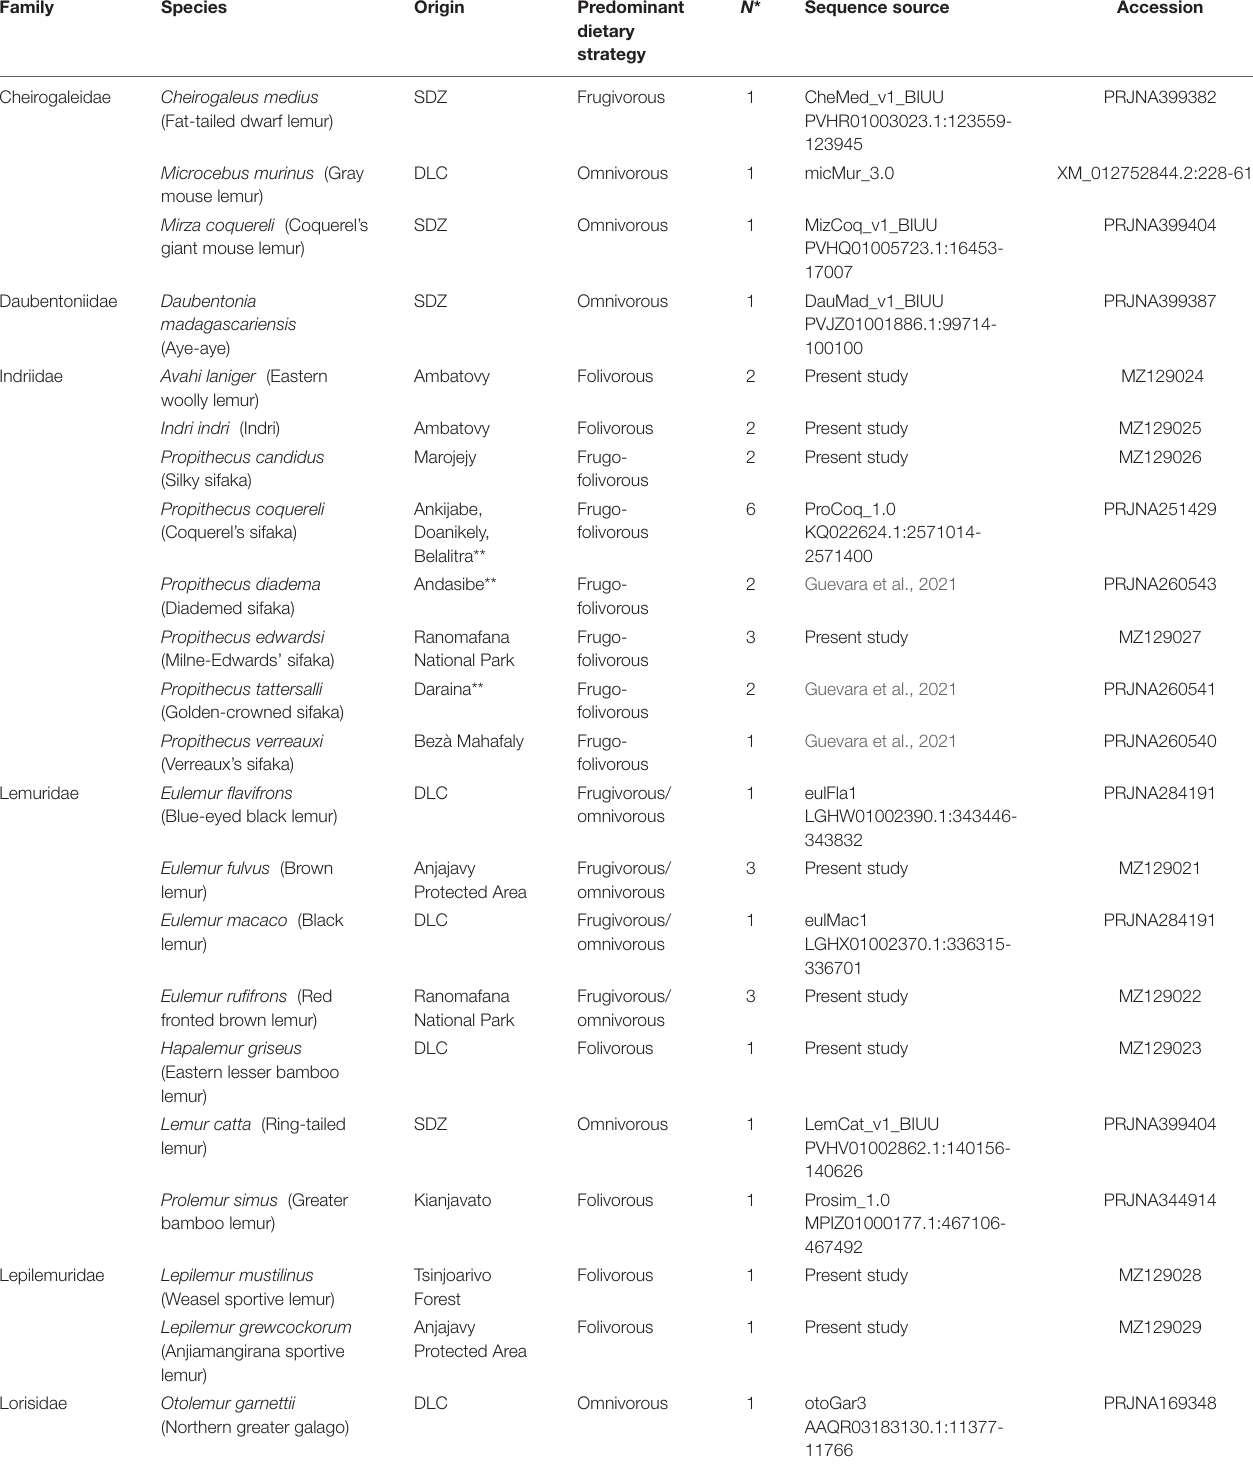
TABLE 1 | Species and samples included in this